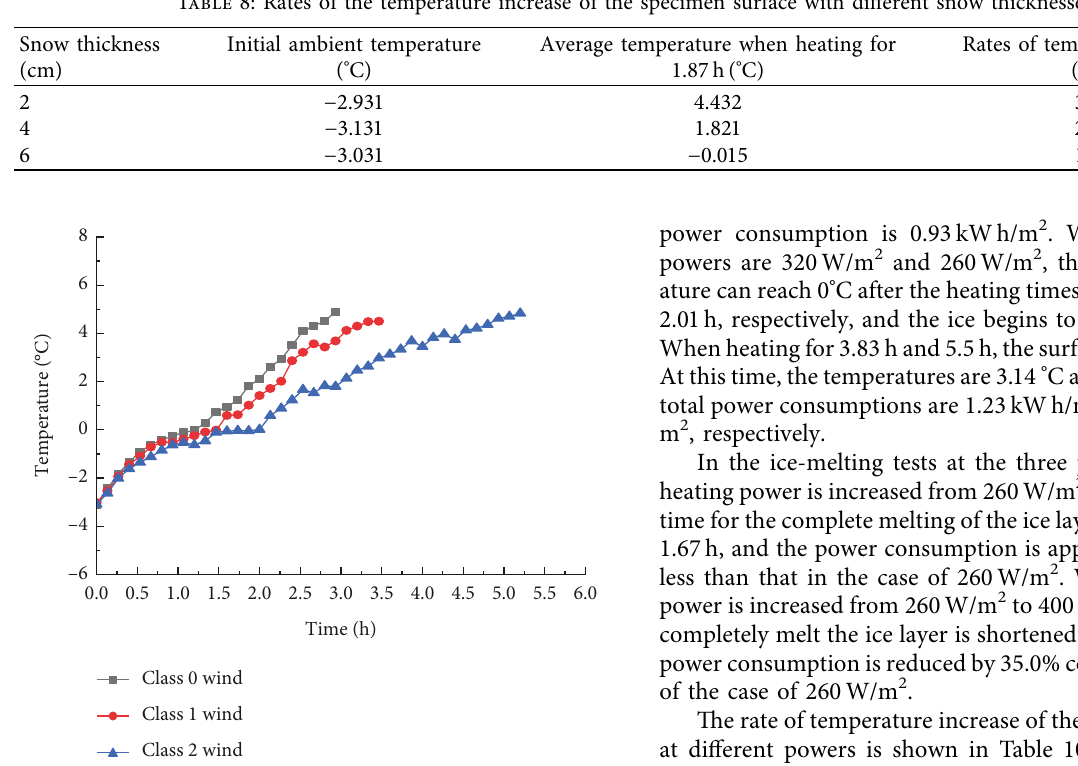
Figure 8: Curve of the surface temperature of the specimen with different wind